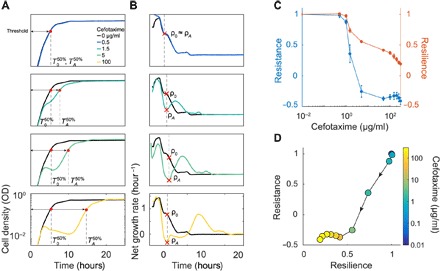
Quantifying resilience and resistance.(A) Time courses are used to quantify a population’s resilience. When no antibiotic was added (black curve), the population grew up unperturbed and reached a target threshold density (here, 50% of the carrying capacity) in time = T50%. If the antibiotic concentration added was very low (blue curve; A = 0.5 μg/ml cefotaxime), then the population reached the threshold density in a similar time to the untreated population. As the antibiotic concentration increased, the degree of lysis increased and affected the time necessary for the treated population to reach the threshold (TA50%). We characterized the population’s resilience for a range of antibiotic concentrations as the inverse ratio of the times to the half-maximal carrying capacity (T050%/TA50%). (B) Net growth rate quantifies population’s resistance. When no antibiotic was added, the population’s net growth rate decreased over time as it consumed the available nutrients and approached stationary phase. When a low dose of antibiotic was added, the net growth was not notably altered (blue curve). In this instance, the treated population’s minimum net growth rate is recorded as ρA and compared to the untreated population’s net growth rate at the same time (ρ0). As the antibiotic concentration increased, the net growth rate curve of the treated population deviated more from the untreated curve. For each antibiotic concentration, ρA was recorded as the net growth rate at the point of maximum negative deviation from the untreated population and normalized by ρ0. We characterized a population’s resistance as the ratio of recovery times (ρA/ρ0). (C) Resistance and resilience as functions of the cefotaxime concentration. At low doses of cefotaxime, the population was resistant and resilient, showing little disturbance after exposure [see (A) and (B)]. As the antibiotic concentration was increased, resistance and resilience decreased due to the increase in cell lysis causing the net growth to decrease and the time to the half-maximum density increased. Once the population underwent a crash, the resistance was minimized and resilience became the dominating factor for survival. (D) The resistance-resilience map defines a phenotypic signature. Using the same data as in (A) to (C), the resistance-resilience framework can visualize the shift in a population’s antibiotic response. When the antibiotic concentration was 0 or very low, the population’s response displayed high resistance and resilience. Once the antibiotic concentration increased to 5 μg/ml, the population’s response shifted to a position where resistance was minimized and resilience dominated the antibiotic response. With further increase in antibiotic concentration, the resistance level continued to decrease. An effective treatment should minimize both resistance and resilience. Dot colors reference the antibiotic concentration used at that point, and arrows indicate the direction of increasing antibiotic concentrations.